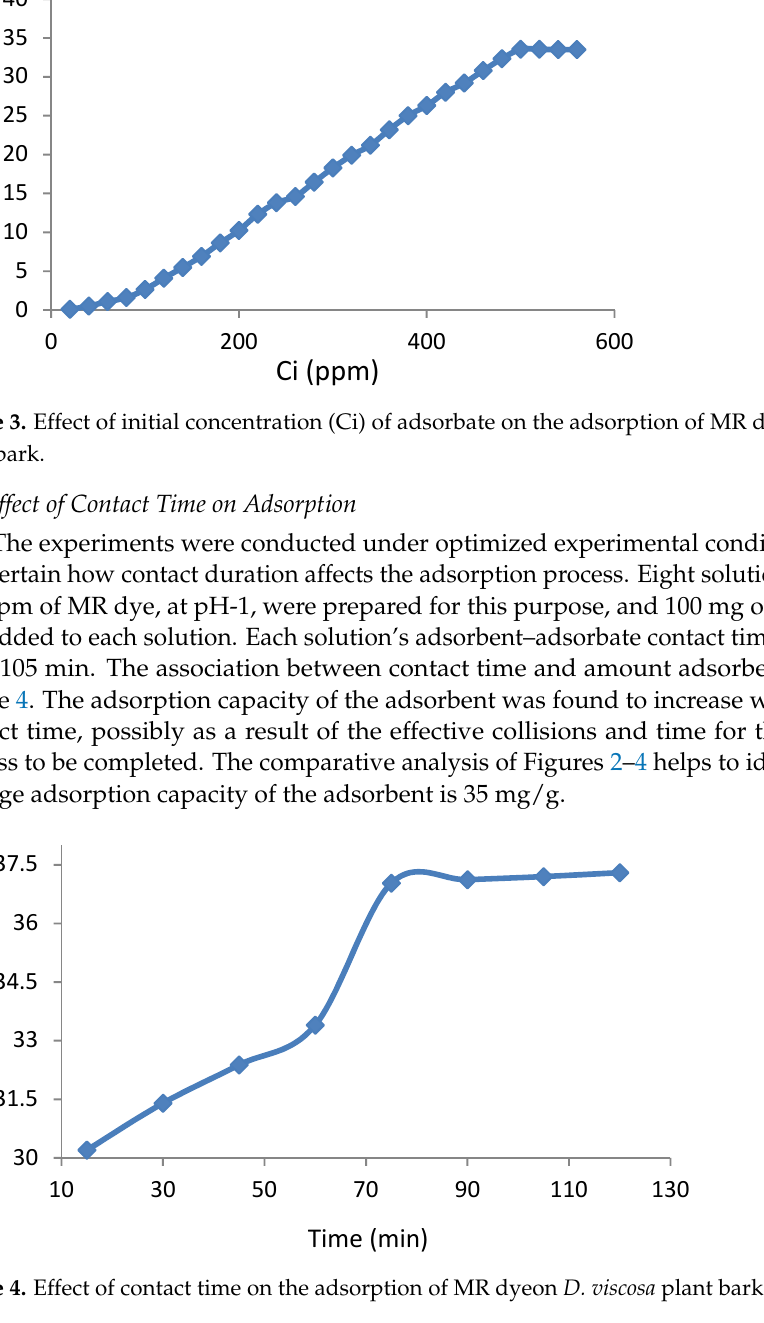
Figure 4. Effect of contact time on the adsorption of MR dyeon D. viscosa plant bark.